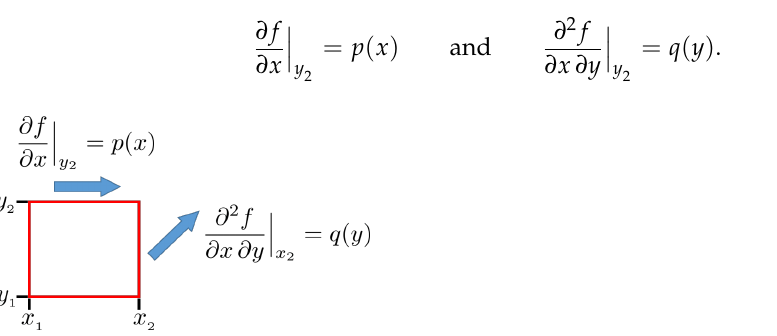
Figure 1. Mixed and shear-type neighboring derivatives